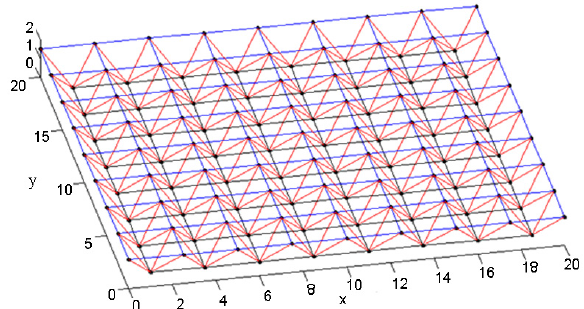
Fig. 7. A square pyramid space grid system